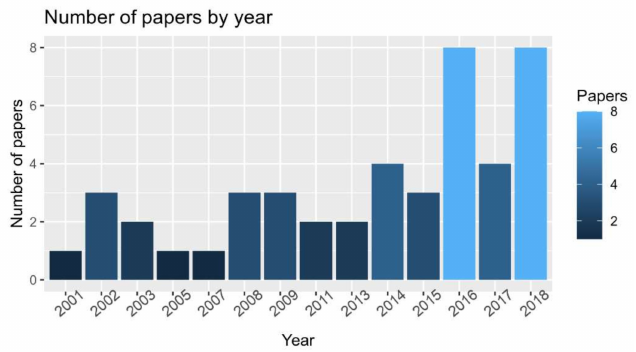
Figure 4. Number of papers per